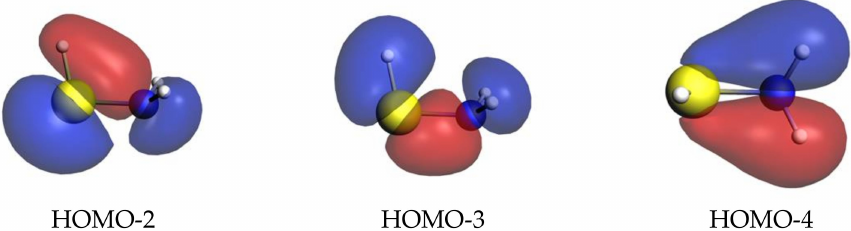
Figure 4. Molecular orbitals of HS–NH 2 mainly responsible for the formation of the S–N bond. Isosurface value 0.03 a.u. Level of theory